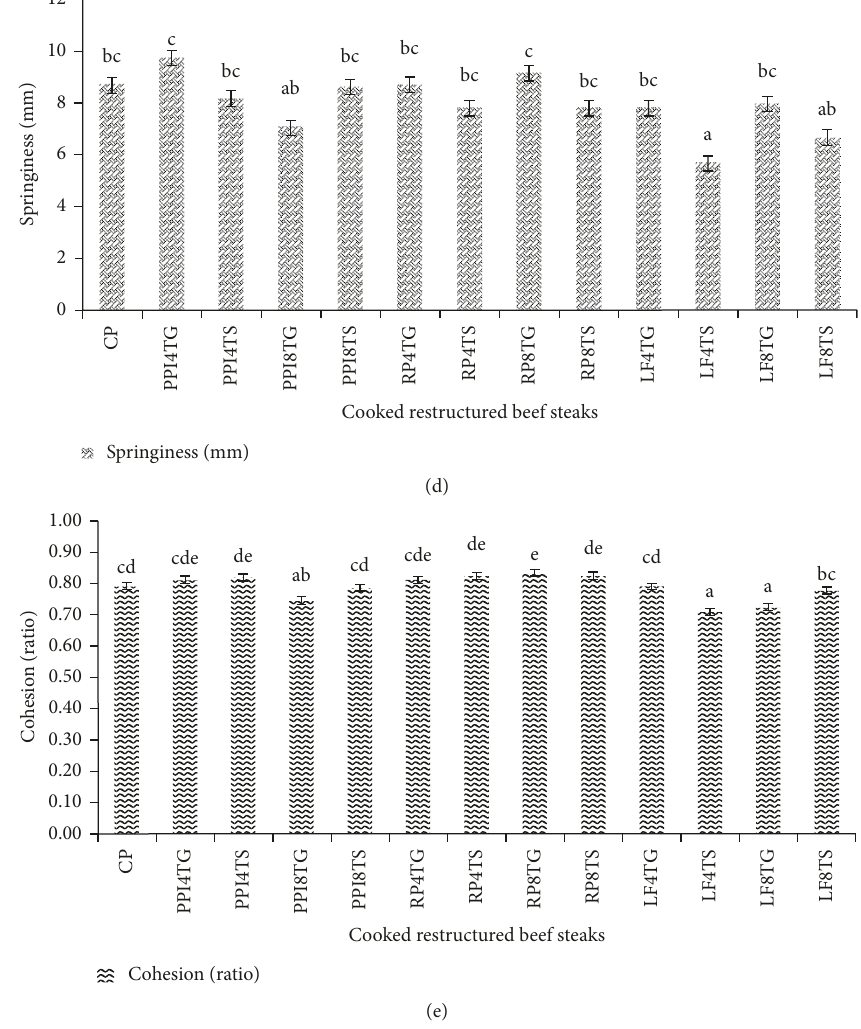
Figure 2: Textural parameter among protein-enriched restructured beef steaks: (a) hardness, (b) chewiness, (c) gumminess, (d) springiness, and (e) cohesiveness. Control (CP), pea protein isolate (PPI), rice protein (RP), and lentil flour (LF) (at 4 and 8%); binding agents: Activa EB (TG) and Transgluseen-M